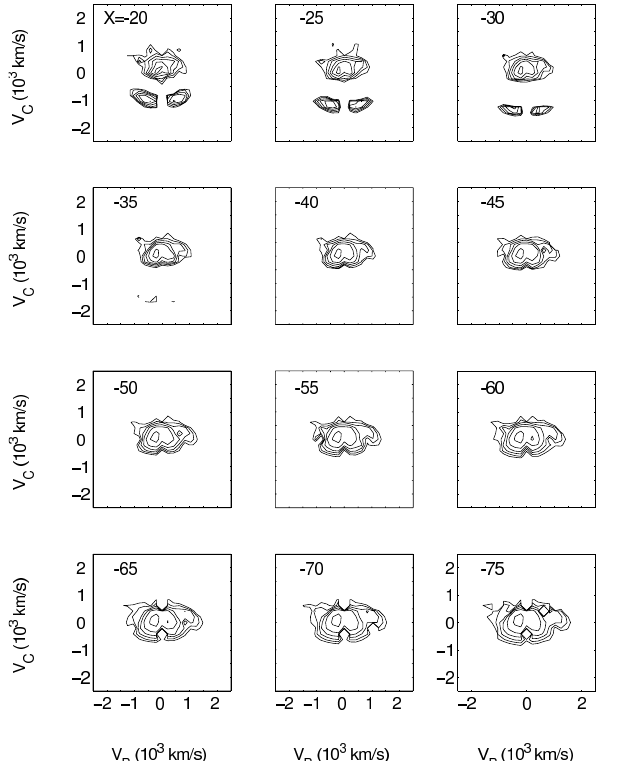
Fig. 14. Model ion velocity distributions shown as two-dimensional distributions in the V B - V C plane. The distribution functions are plotted for different downtail positions, from X = − 20 R E to − 75 R E . The X -positions are indicated in each subplot.